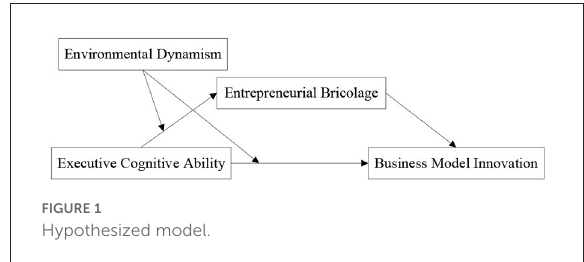
FIGURE1 Hypothesized